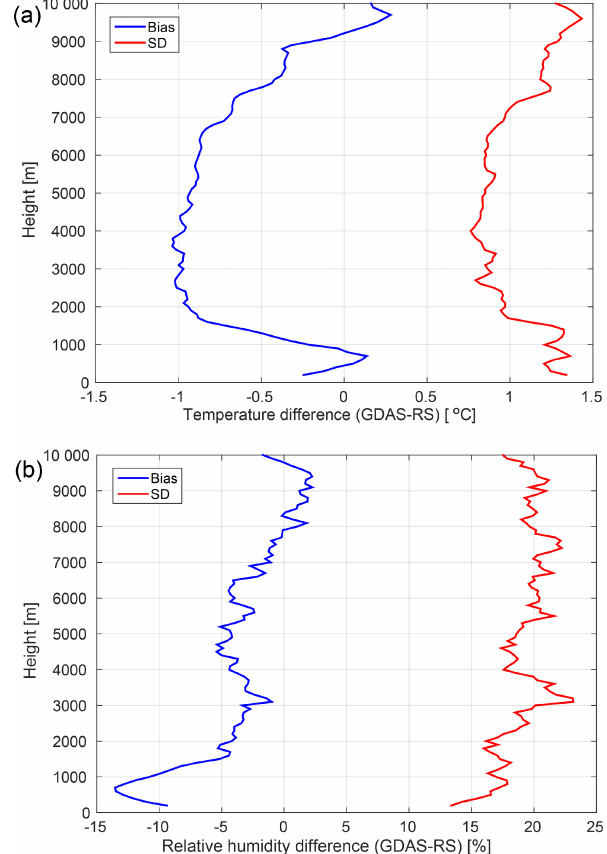
Figure 1. Difference in temperature (a) and relative humid- ity (b) between GDAS1 and radiosonde data. Radiosondes for the period from February 2017 to July 2017 at Ny-Ålesund are used. Blue and red lines show the bias and the standard deviation, respec-